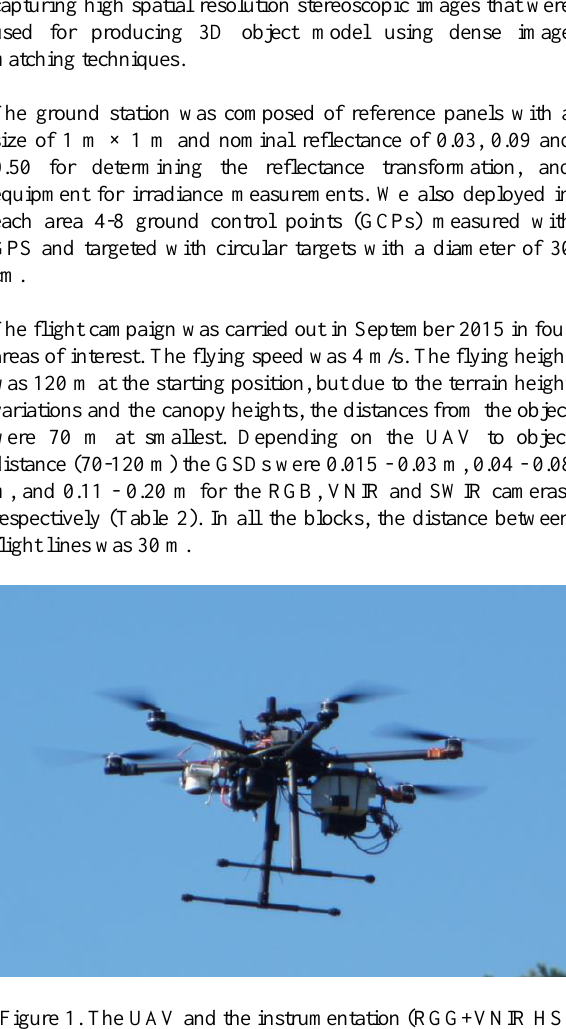
Figure 1. The UAV and the instrumentation (RGG+VNIR HS sensors) used in the UAV